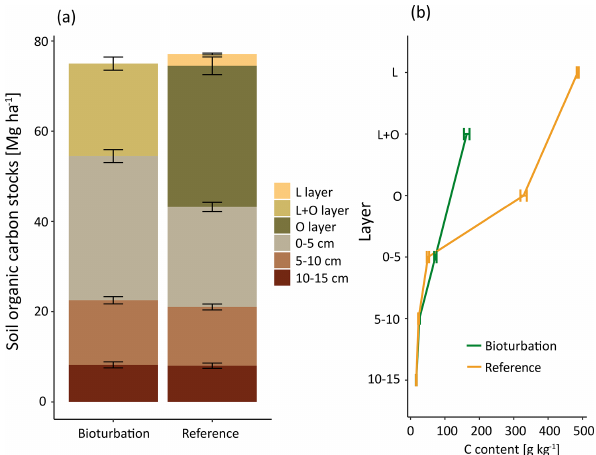
Figure 2. (a) Mean soil organic carbon (SOC) stock (Mgha − 1 ) distribution, significant differences were found in 0–5cm depth and in the combined forest floor (L + O layer). (b) SOC content (gkg − 1 ) in different layers and soil depth increments for plots in the treatment mimicking wild boar grubbing (Bioturbation) and in the undisturbed control subplots